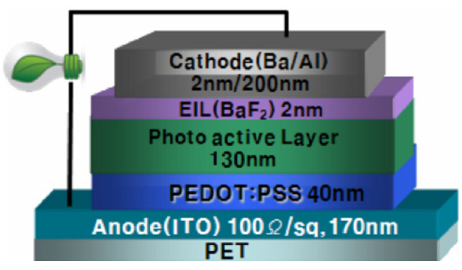
Figure 22. Device structure of a flexible polymer solar cell [80].